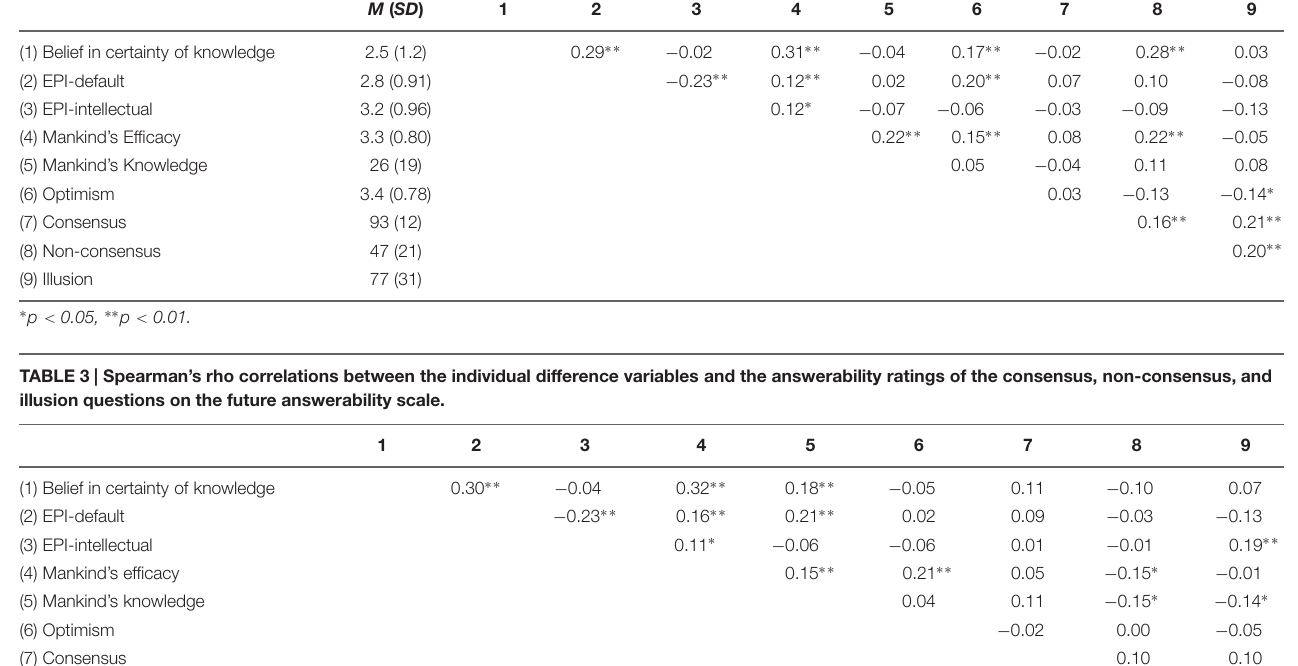
TABLE 2 | Current answerability scale ratings: means and SDs and Pearson correlations between the individual difference variables and the answerability ratings of the consensus, non-consensus, and illusion questions. M ( SD )